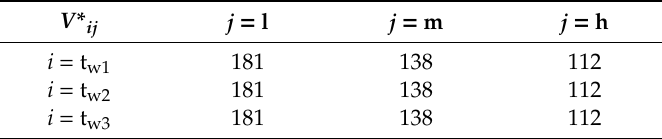
Table A6. Post-COVID volumes for the 9 treatment groups in